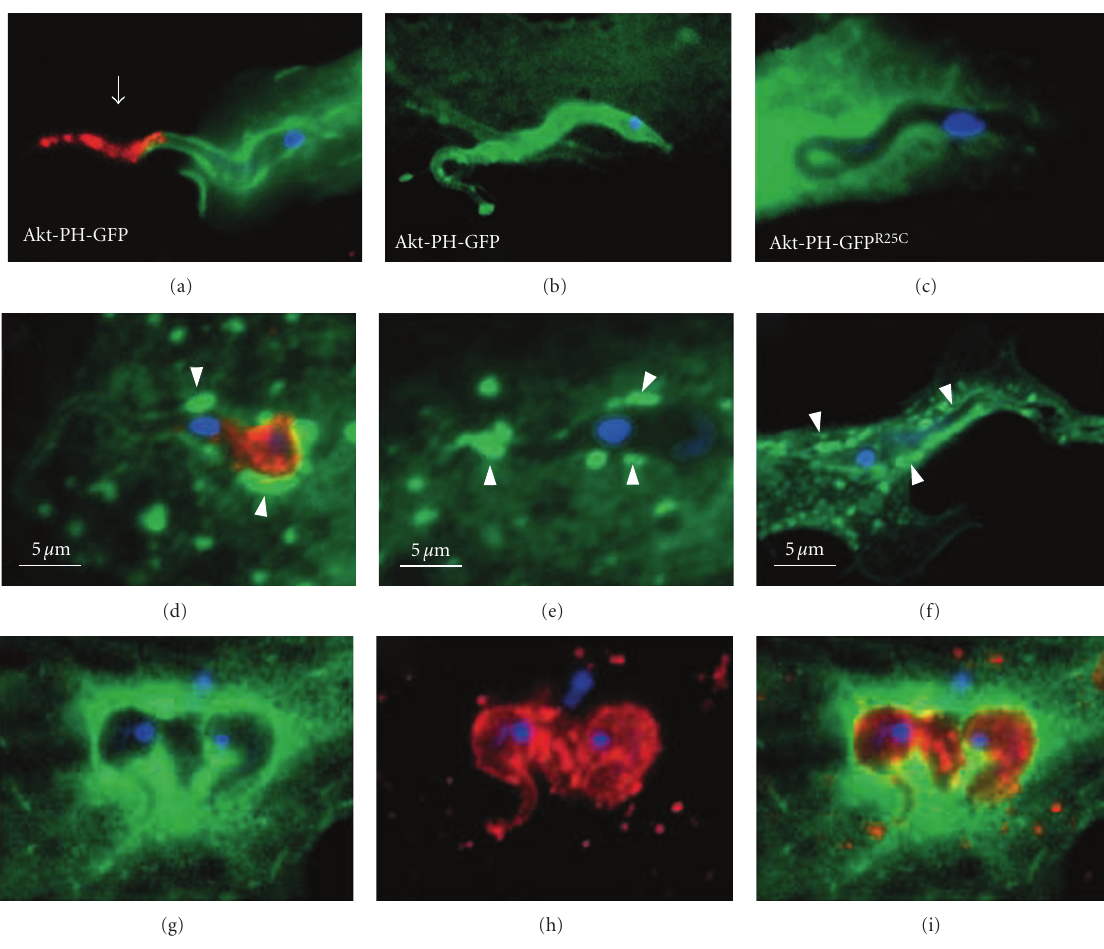
Figure 7: Trypomastigote vacuole is enriched in AKT-PH-GFP that binds to posphatidylinositolbiphosphate (PtdIns(3,4)P 2 ) and phosphatidylinositoltriphosphate (PtdIns(3,4,5)P 3 ) that are products of PI3 Kinase (a–c) and also labeled to EEA1 and Rab 5 (d–f) and Lamp-1 (g–i). (a–c) rapid accumulation of PtdIns(3,4,5) P 3/PtdIns (3,4) P 2 at the T. cruzi invasion site. Fluorescence images of (a) CHO cells or (b) primary rat cardiomyocytes transiently expressing Akt-PH-GFP following incubation with infective T. cruzi trypomastigotes for 15 minutes. (c) T. cruzi invasion of CHO cells expressing Akt-PH-GFP R25C which fails to bind to PtdIns (3,4,5) P 3/PtdIns(3,4) P 2. (d)–(f): early association of T. cruzi with early endosomes is minimal and precedes lamp-1 acquisition. Immunofluorescence staining of extracellular T. cruzi (arrowheads) following infection of CHO cells transiently expressing Rab5-GFP (green). Host cell and parasite DNA is visualized with DAPI (blue). (g–i) lamp-1 association with the Akt-PH-GFP-enriched T. cruzi vacuole occurs after parasite entry. L6E9 myoblasts expressing Akt-PH-GFP (green) were infected with T. cruzi for 60 minutes and stained with anti-lamp-1 (red) and DAPI (blue). Bars = 5 μ m (after